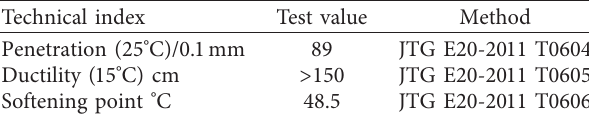
Table 1: Basic properties of the matrix